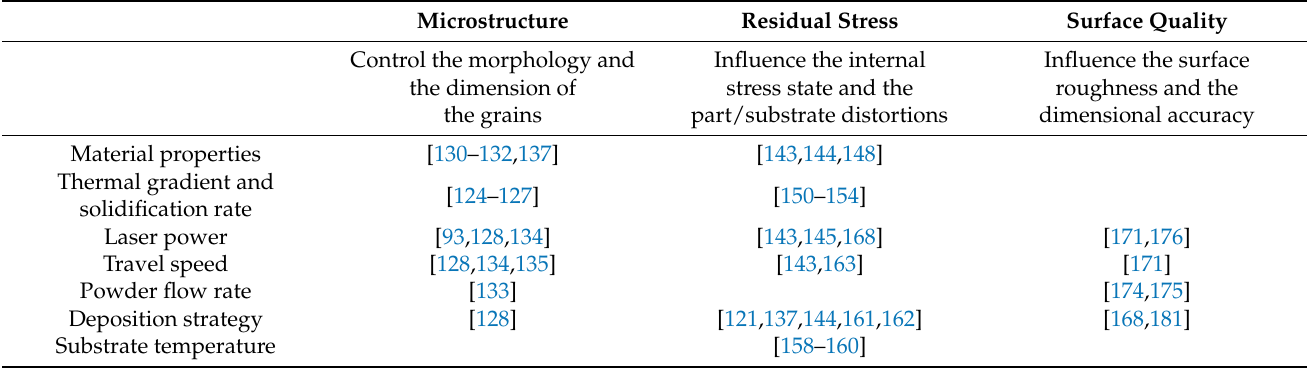
Table 5. Summary of the factors influencing the solidification